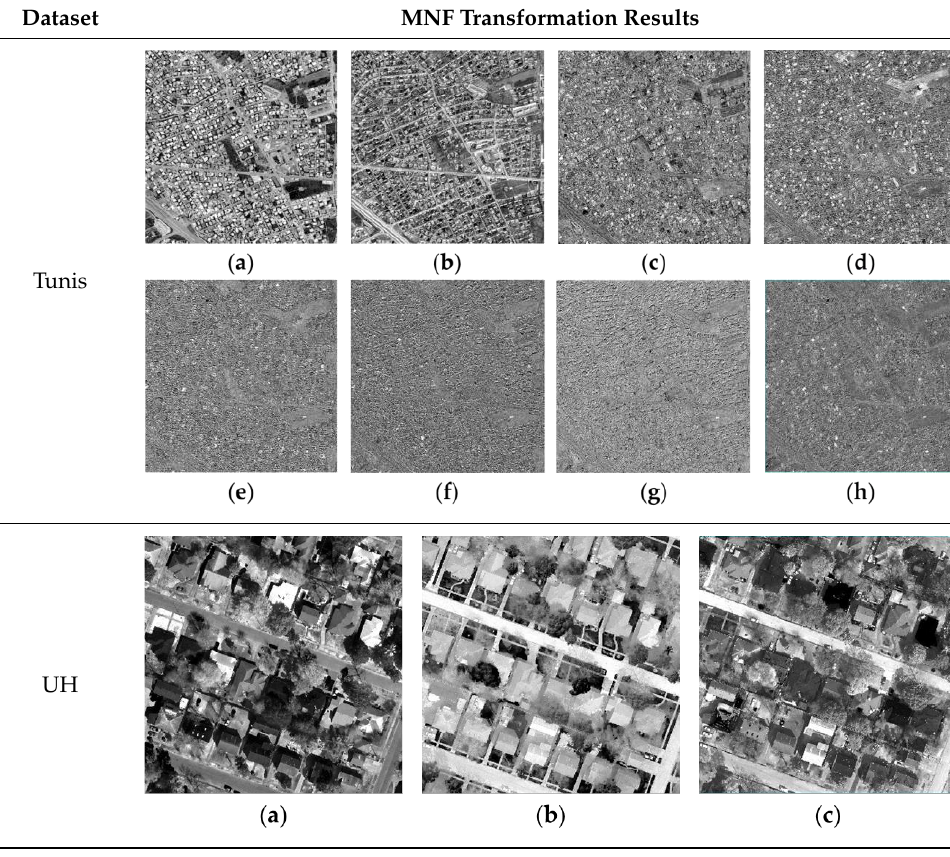
Table 8. Statistics of MNF bands. Dataset Vaihingen